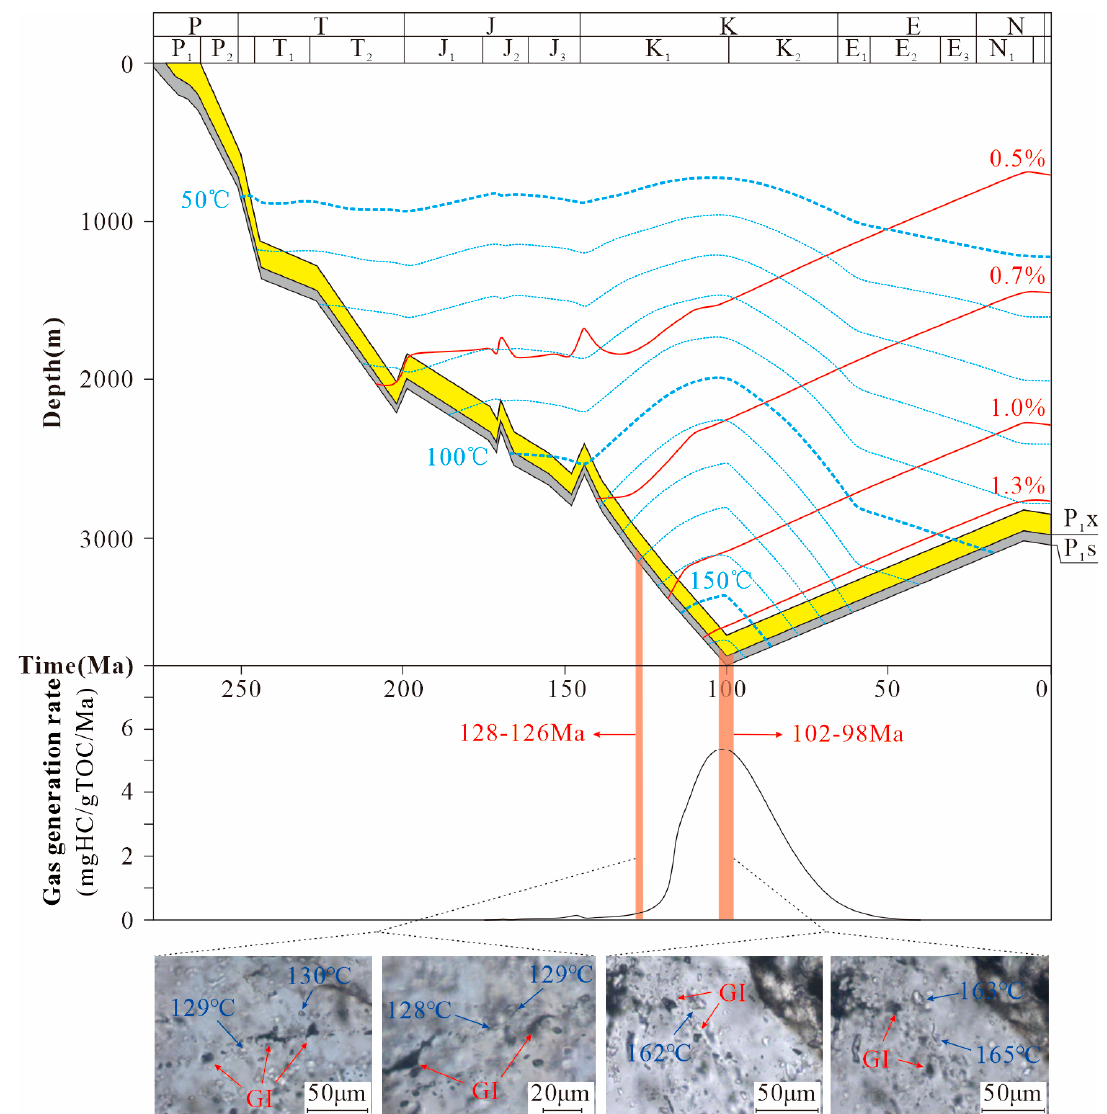
Figure 10. Plots showing the burial and thermal evolution histories, and gas generation and charg- ing histories of well J57.